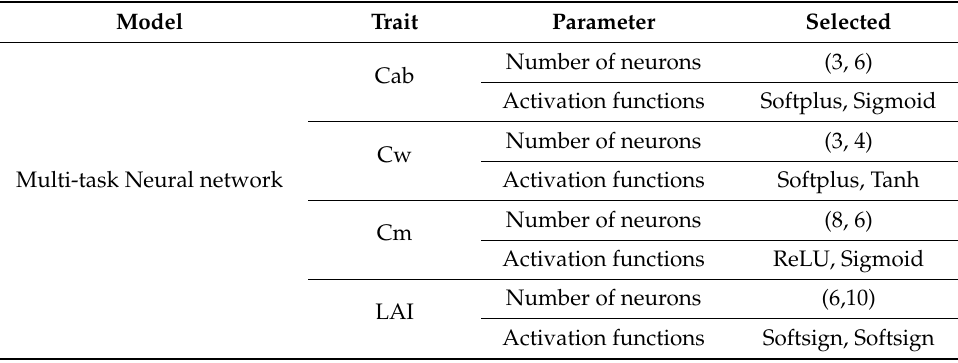
Table 5. Summary of selected hyperparameters for the trait-specific